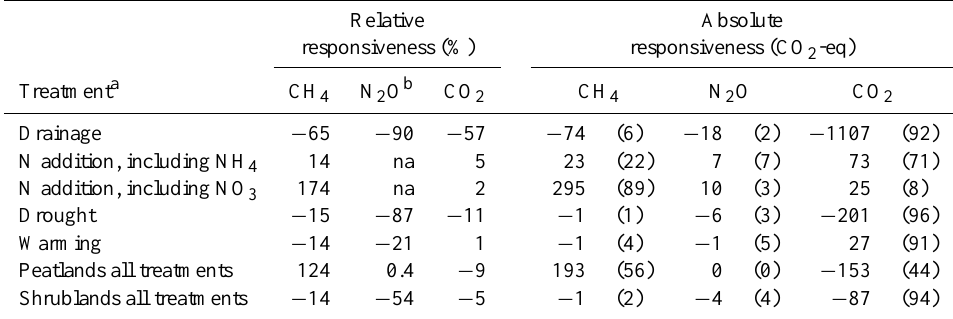
Table 4. Relative responsiveness to treatments compared to controls (%), absolute responsiveness (CO 2 -equivalents), and fractional impor- tance of each greenhouse gas to the total numerical global warming response (in brackets, %) for soil CH 4 , N 2 O and CO 2 fluxes across all